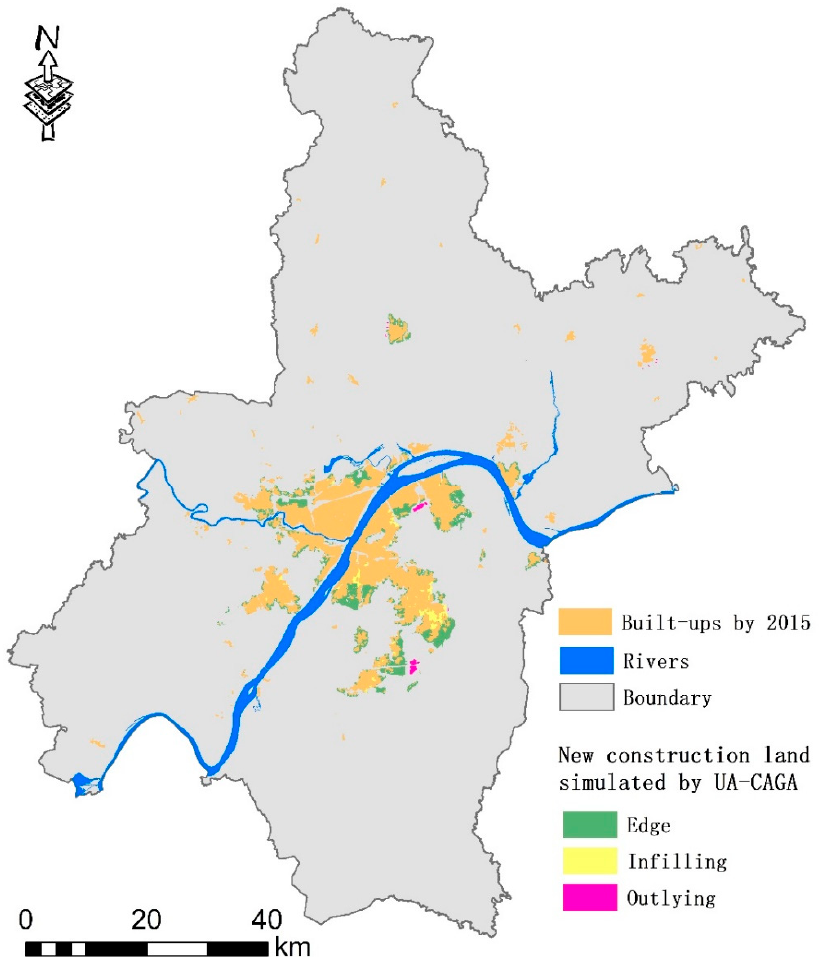
Figure 3. The 2025 spatial distributions of the three simulated expansion types using the UV-CAGA model.